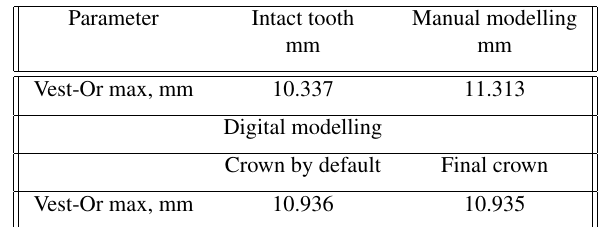
Table 2. Maximal vestibular-oral dimensions measured on teeth and crowns